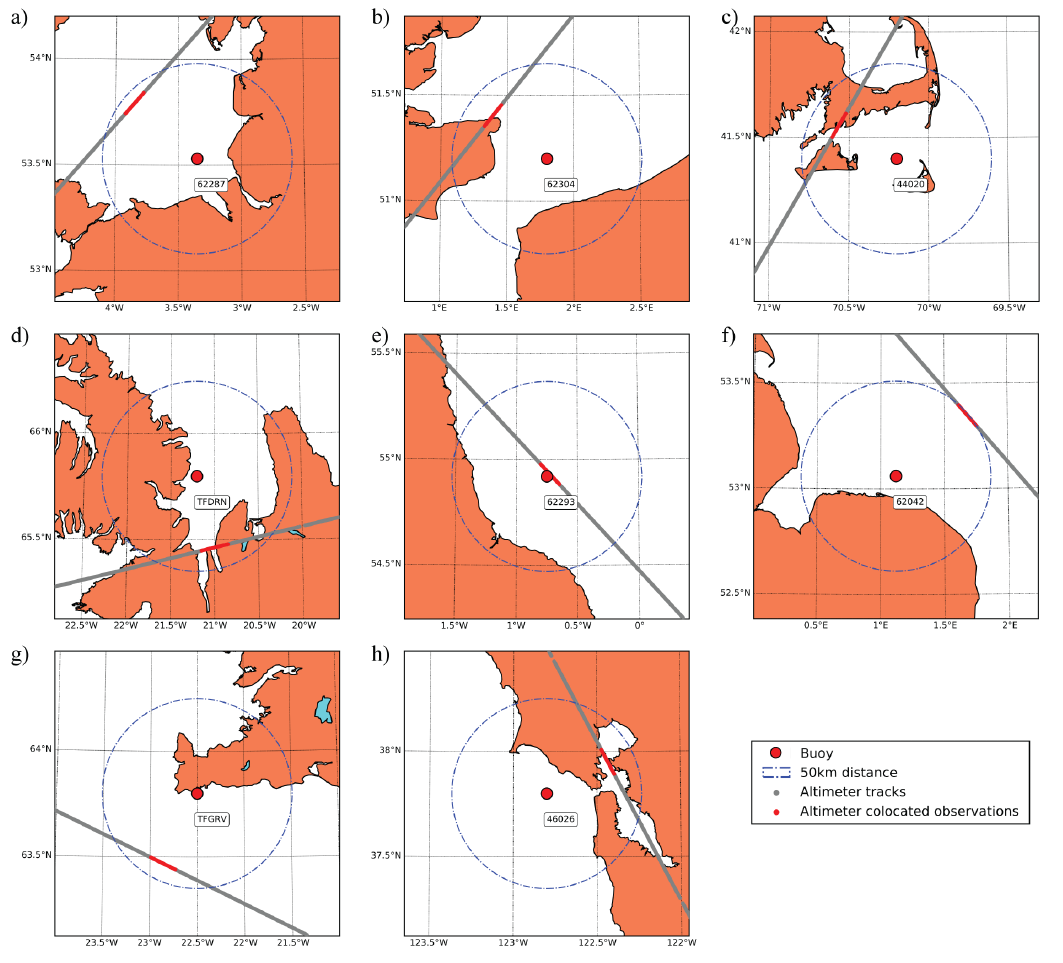
Figure 3. Locations of eight wave buoys, with nearest altimeter track by Jason-3, showing the variation in the quality of match-ups. ( a ) Buoy 62287 off Liverpool, UK. ( b ) Buoy 62304 in English Channel ( c ) Buoy 44020 off Barnstable, MA, USA. ( d ) Buoy TFDRN off NW Iceland. ( e ) Buoy 62293 off Humberside, UK. ( f ) Buoy 62042 off Norfolk, UK. ( g ) Buoy TFGRV off SW Iceland ( h ) Buoy 46026 off San Francisco, CA, USA. The blue circle indicates 50 km radius from the buoy, with the red segment of track indicating the 51 nearest points to the